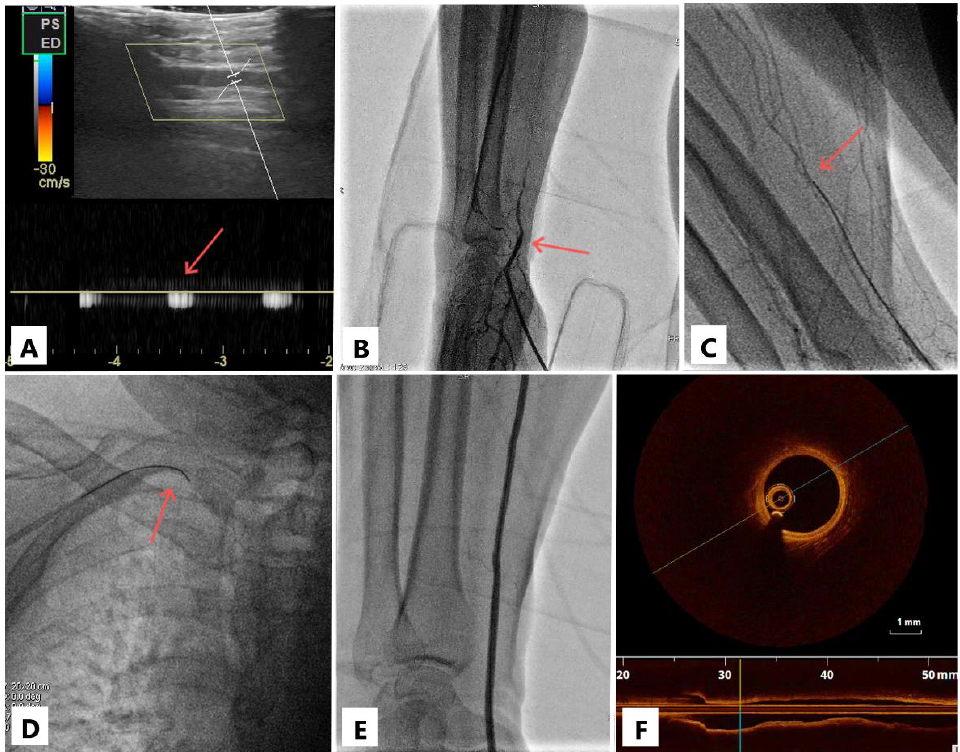
Figure 1. Case illustration. Doppler sign in the distal radial artery (panel ( A ), arrow); visualization of the radial artery occlusion (panel ( B ), arrow); the occlusion passage with a 0.018 ″ guidewire (panel ( C ), arrow) on which the sheathless catheter is then advanced (panel ( D ), arrow); after coronary angioplasty, the radial artery is visualized both with contrast (panel ( E )) and by optical coherence tomography (panel ( F )); note the three-layered structure of the arterial wall (intima, media, adventitia) suggestive of a normal morphology.